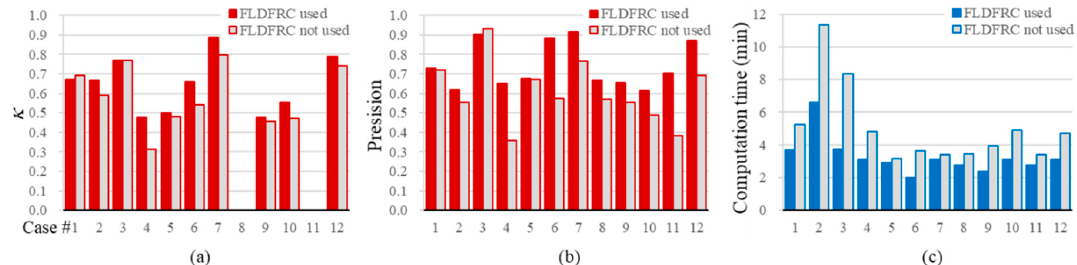
Figure 6. Comparison of flood detection results with and without FLDFRC (flood simulation): ( a ) Kappa coefficient κ ; ( b ) Precision; ( c ) computation time.